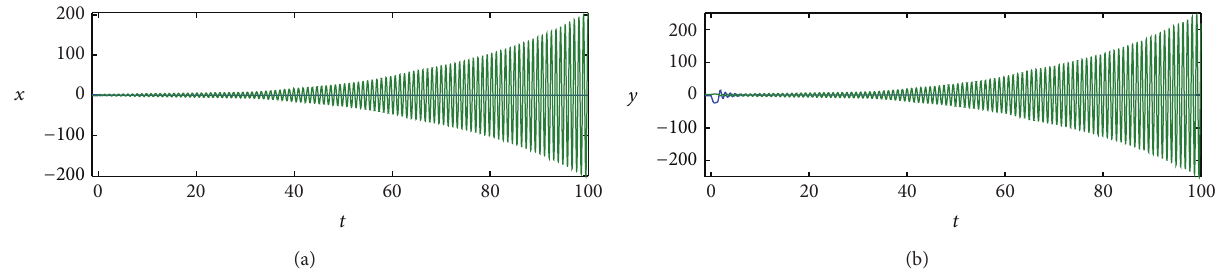
Figure 1: State trajectory of the system with 𝜌 1 = 𝜌 2 = 0.24 for Example 7 with two nodes.